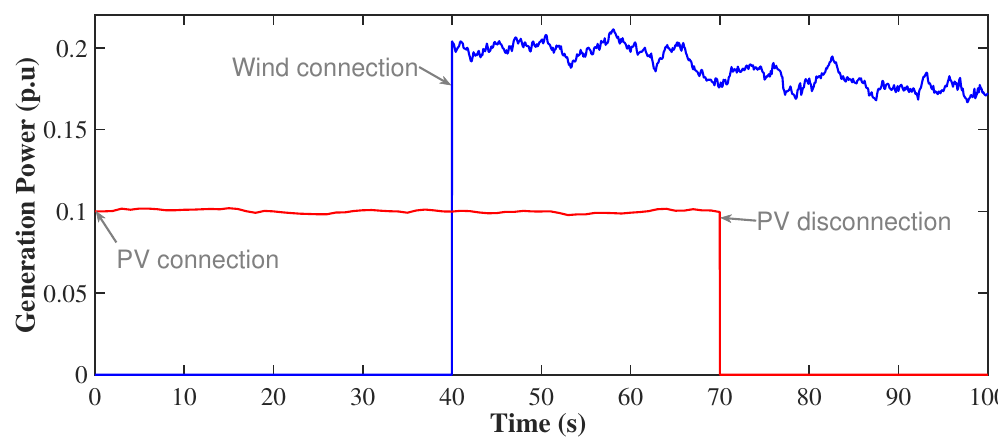
Figure 16. The loading/generation profiles for scenario 4.